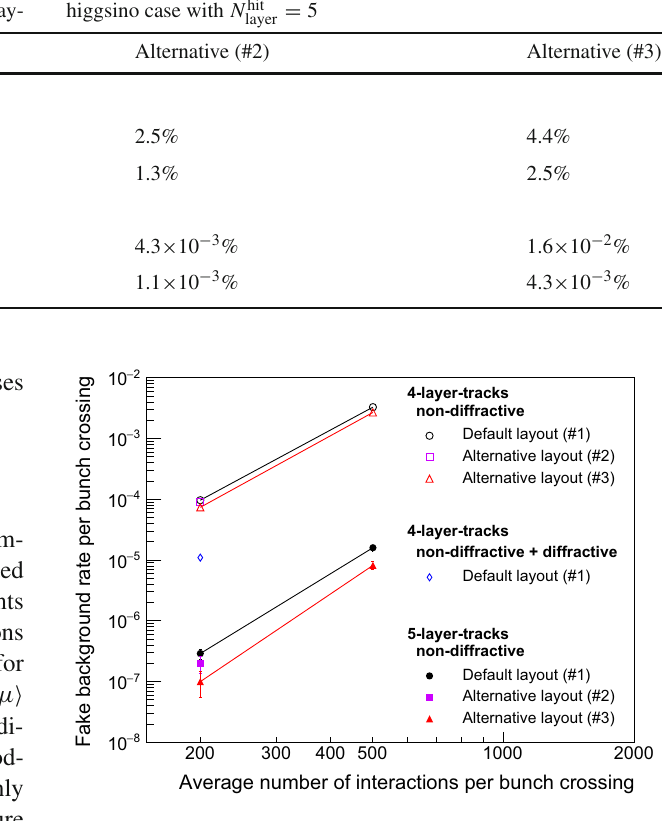
Fig. 4 Probabilityoffindingafaketrackinaneventasafunctionofthe average number of pp interactions per bunch crossing ( (cid:8) μ (cid:9) ). The prob- = 4 (5) are shown by abilities for the tracks reconstructed with N hit layer the open (filled) markers, and they are presented separately for the three tracker layouts: the default layout (#1) in black circles, the alternative layouts of #2 in magenta squares and #3 in red upward triangles. The probabilities for the layout #2 are shown only at (cid:8) μ (cid:9) = 200. The esti- mate from the mixed sample of non-diffractive and diffractive events for the default layout is shown by the blue diamond for comparison